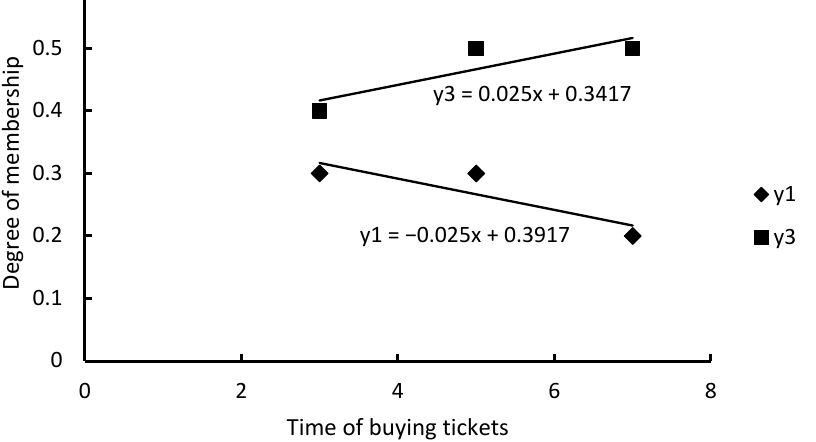
Figure A33. Single factor evaluation for the index of time of buying tickets (4–7 days before departure).